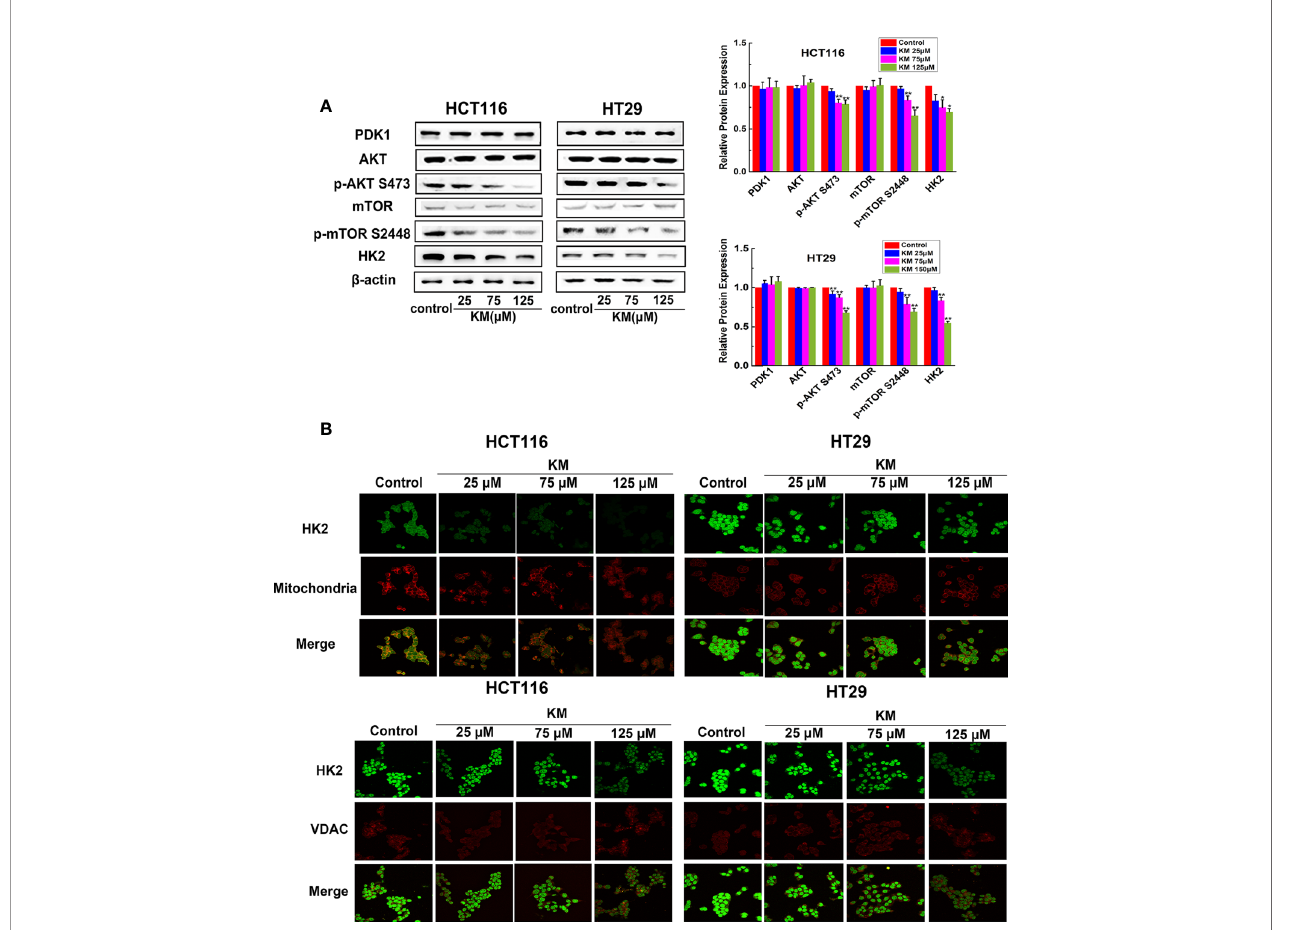
FIGURE 5 | KM repressed glycolysis and promoted the dissociation of HK2 from mitochondria and VDAC by downregulating Akt/mTOR/HK2 pathway in CRC cells. (A) Effect of KM on the expression level of Akt/mTOR/HK2 pathway by targeting PDK1. Protein levels were measured by Western blot analysis. (B) Representative immuno fl uorescence confocal images of CRC cells labelled with HK2, VDAC antibody and Mito-Tracker. Data were presented as mean ± SD (n = 3); signi fi cance: * P < 0.05, ** P < 0.01 vs